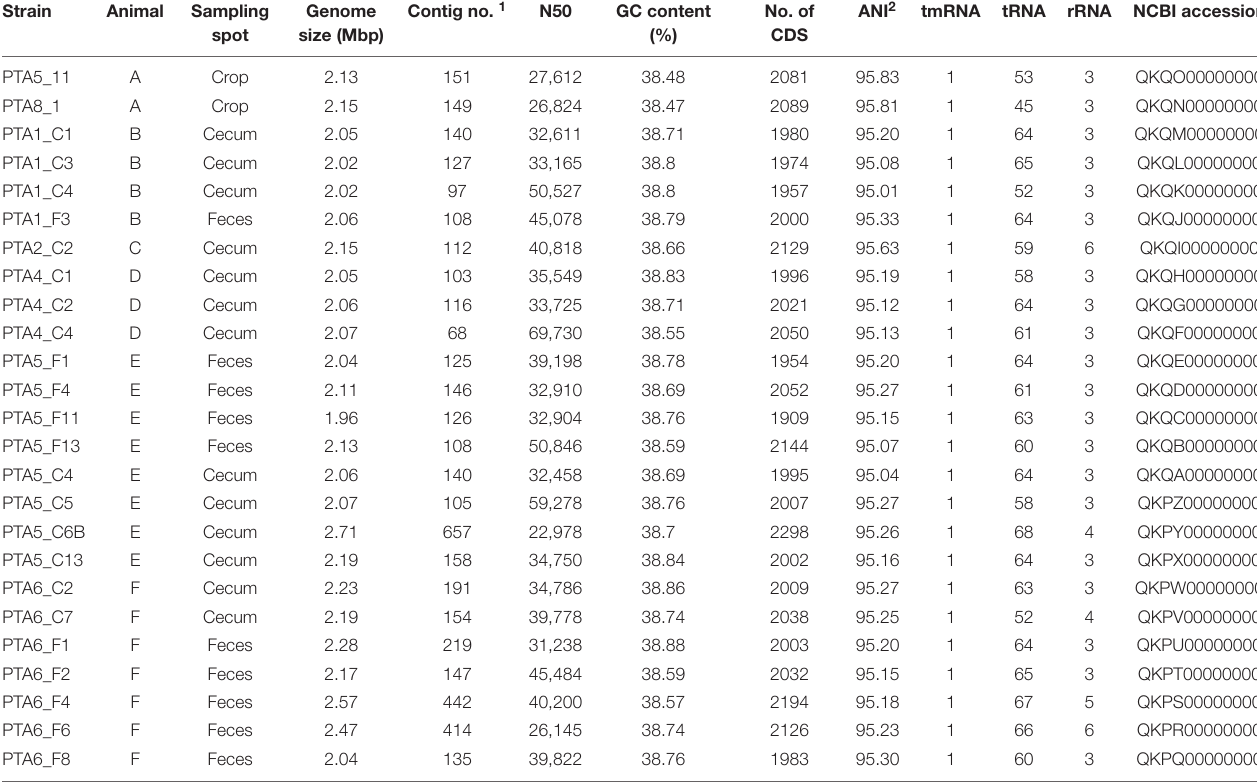
TABLE 1 | Draft genome features of 25 L. reuteri strains isolated from chicken GIT and sequenced in this study. Strain Animal Sampling Genome Contig no. spot size (Mbp)